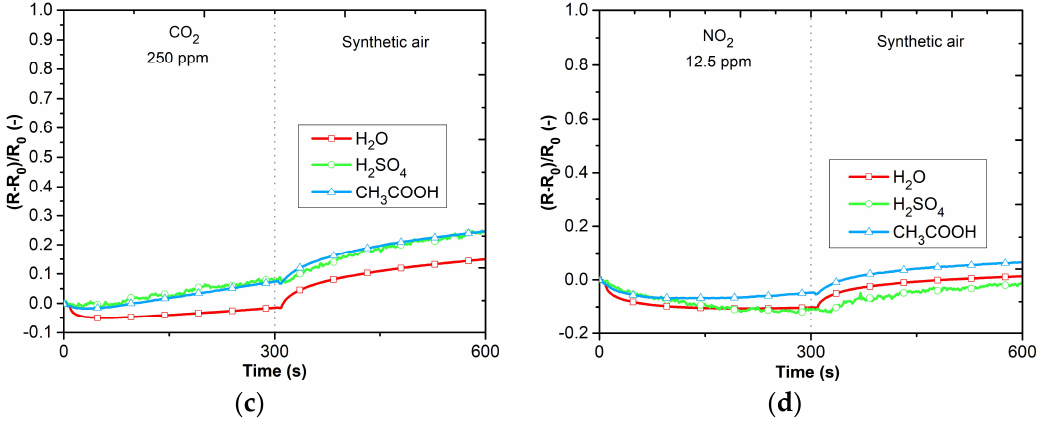
Figure 9. Responses of active layers: ( a ) reaction to NH 3 , ( b ) reaction to CO, ( c ) reaction to CO 2 , ( d ) reaction to NO 2 .